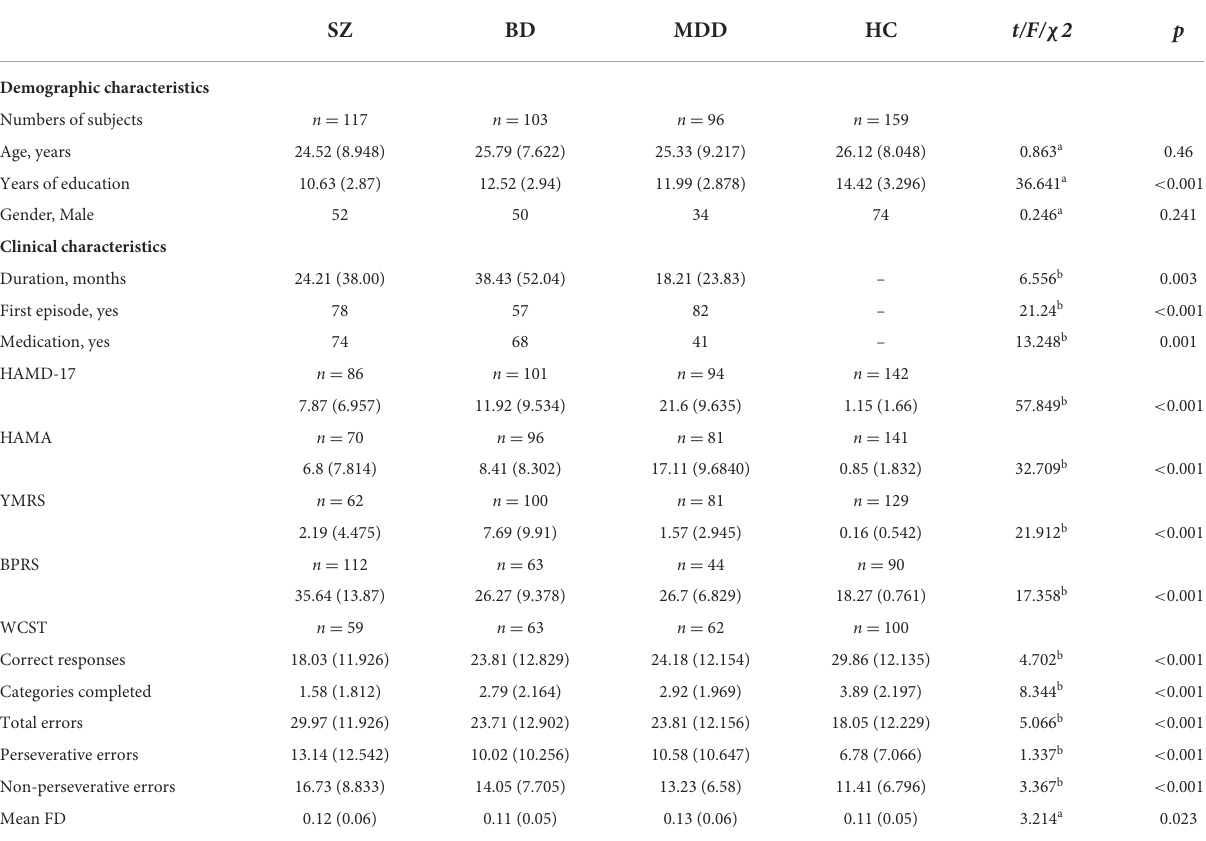
TABLE 1 Demographic and clinical